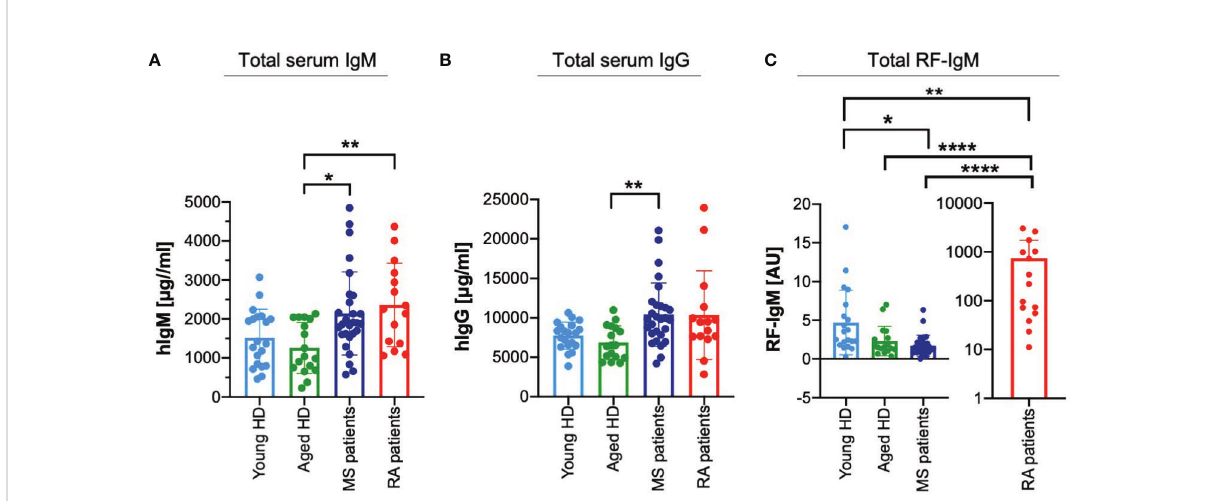
FIGURE 6 Deregulated ratios of high af fi nity and low af fi nity RFs in autoimmune diseases. (A) Total IgM amount detected in serum from young (light blue bar, n = 20) and aged (green bar, n = 17) healthy donors (HD), multiple sclerosis (MS) patients (blue bar, n = 28) and rheumatoid arthritis (RA) patients (red bar, n = 15) as measured by ELISA. Bars depict mean ± SD, individual values are represented by single dots. Statistical signi fi cance was calculated using Kruskal Wallis test. *p < 0,05; **p < 0,01. Mean values of IgM ( m g/ml) as follows: young HD 1517.55; aged HD 1258.02; MS patients 2143.72; RA patients 2361.29. (B) Total IgG amount detected in serum from young (light blue bar, n = 20) and aged (green bar, n = 17) healthy donors (HD), multiple sclerosis (MS) patients (blue bar, n = 28) and rheumatoid arthritis (RA) patients (red bar, n = 15) as measured by ELISA. Bars depict mean ± SD, individual values are represented by single dots. Statistical signi fi cance was calculated using Kruskal Wallis test. ** p < 0,01. Mean values of IgG ( m g/ml) as follows: young HD 7733.22; aged HD 6856.48; MS patients 10419.28; RA patients 10345.23. (C) Total RF-IgM amount detected in serum from young (light blue bar, n = 20) and aged (green bar, n = 17) healthy donors (HD), multiple sclerosis (MS) patients (blue bar, n = 28) and rheumatoid arthritis (RA) patients (red bar, n = 15) as measured by ELISA. (coating: human IgG). Bars depict mean ± SD, individual values are represented by single dots. Values from RA patients plotted separately for simpli fi ed visualization. Statistical signi fi cance was calculated using Kruskal Wallis test. *p < 0,05; **p < 0,01; ****p < 0,0001. Mean values of RF-IgM (AU) as follows: young HD 4.71; aged HD 2.31; MS patients 1.72; RA patients